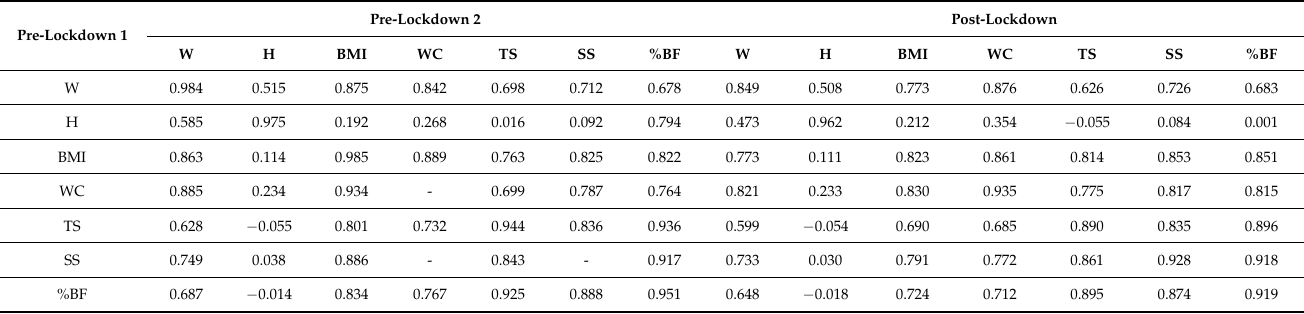
Table 3. Correlation results of pre-confinement 1, pre-confinement 2 and post-confinement anthropometric parameters. Pre-Lockdown1